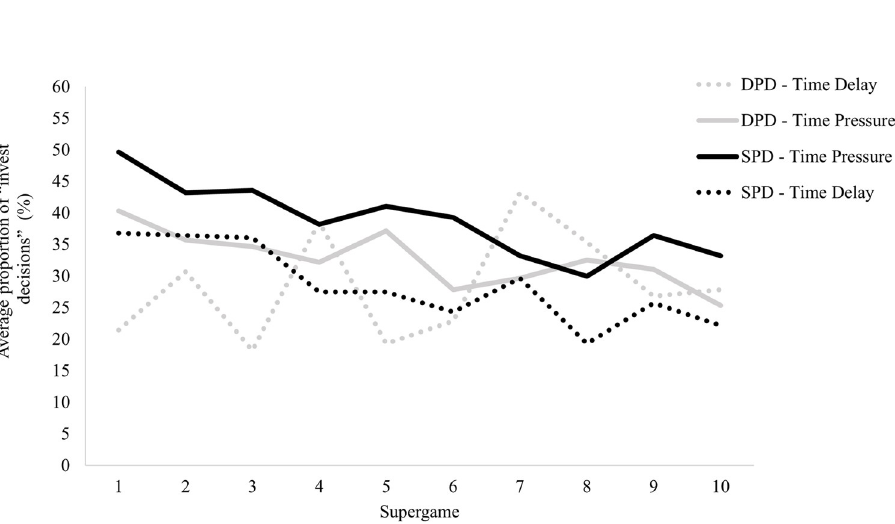
Fig 4. Cooperation rates across the ten supergames played in the four conditions. n = 28 participants in each condition presented. A version of this figure with error bars is presented in the supporting information (S1 Fig).